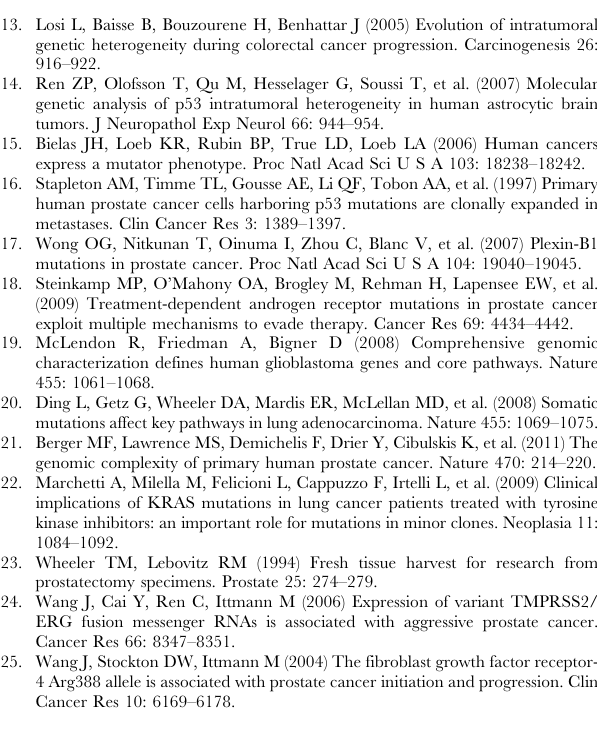
target mutations were used in PCR to generate GGAP2 expression constructs containing 9 different missense mutations. Primers used are shown in Table 4. Dpn1enzyme was added to PCR products